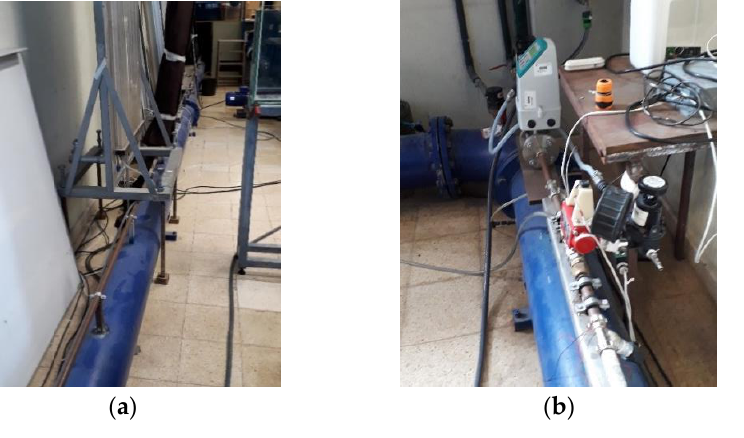
Figure 3. Experimental test facility: ( a ) upstream anchored copper pipe; ( b ) downstream pipe end; and ( c ) pneumatically actuated ball valve.